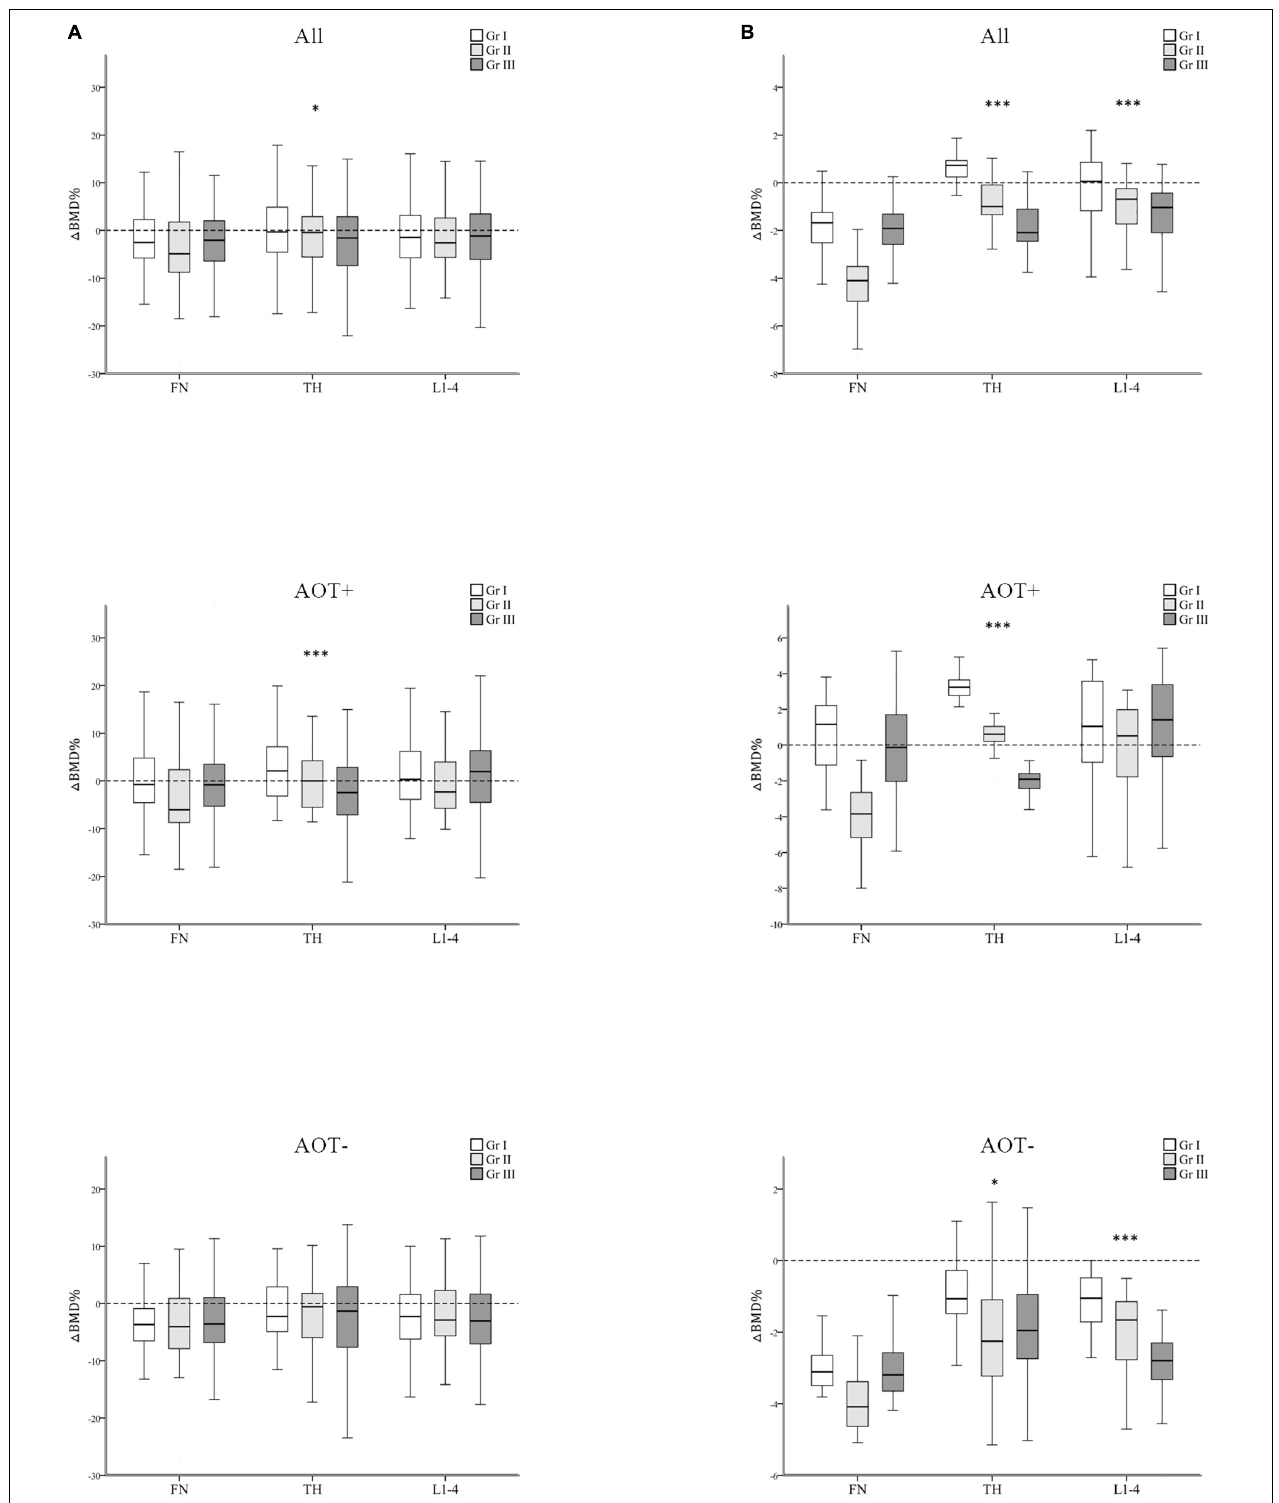
FIGURE 4 | Regression-adjusted percentage change in BMD ( (cid:49) BMD%) from baseline in groups I–III, after matching in all participants and participants with or without anti-osteoporotic therapy (AOT). Unadjusted (A) and regression-adjusted (B) percentage of change in BMD at the femoral neck (FN), total hip (TH), and first through fourth lumbar vertebra (L1–4) after 3 years in groups I–III, combined with AOT presence. Box-and-whisker plots showed the median, interquartile range, and extreme values. ∗ p for trend < 0.05; ∗∗∗ p for trend < 0.005.